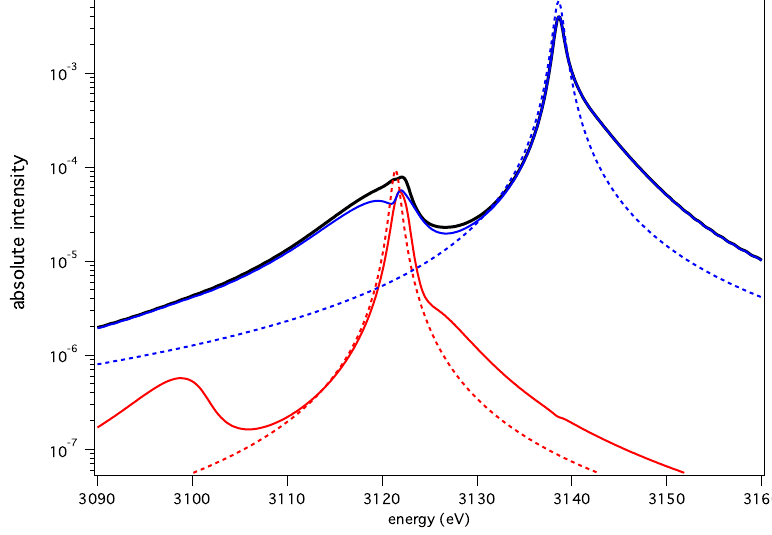
Figure 6. The He- (cid:11) line calculated within the quasi-static approximation for T = 1 keV = 2 (cid:2) 10 24 cm (cid:0) 3 . (Black line) the entire profile; (blue line) resonant line profile; and n e (red line) intercombination line profile. The pure electron-broadened profiles are plotted in dashed lines for each component.